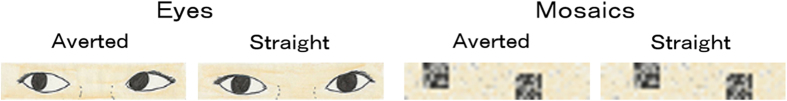
Schematic illustrations of stimuli.The actual stimuli were created using photographs of faces.